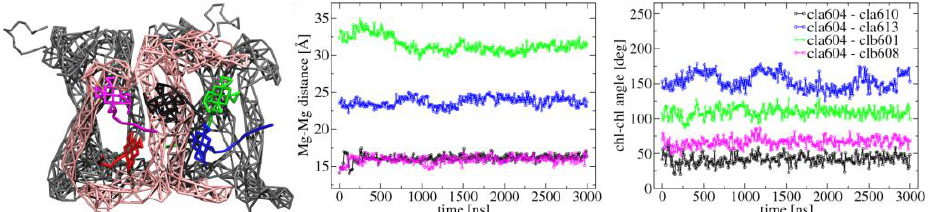
Fig. 2. Side view of the LHCII trimer (left). The protein backbone of the monomer which embeds the depicted chlorophylls is colored pink; the other two gray. Chlorophyll a 604 is colored in red; chlorophyll a 610 black; chlorophyll a 613 blue; chlorophyll b 601 green; chlorophyll b 608 magenta. In addition, the Mg-Mg distances (middle) and the angles between the aromatic rings (right) between chlorophyll a 604 (red) and the other chlorophylls are depicted. The lines are colored